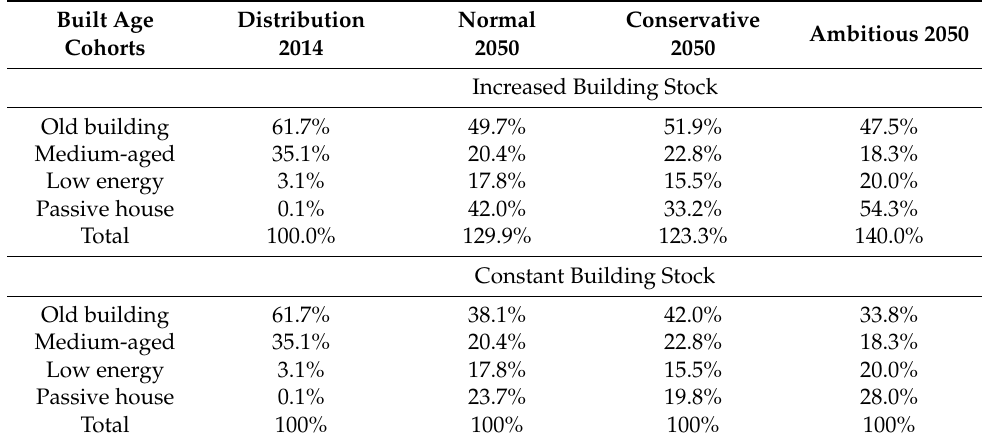
Table 4. Comparison of building stock distribution in 2014 and 2050 under the different